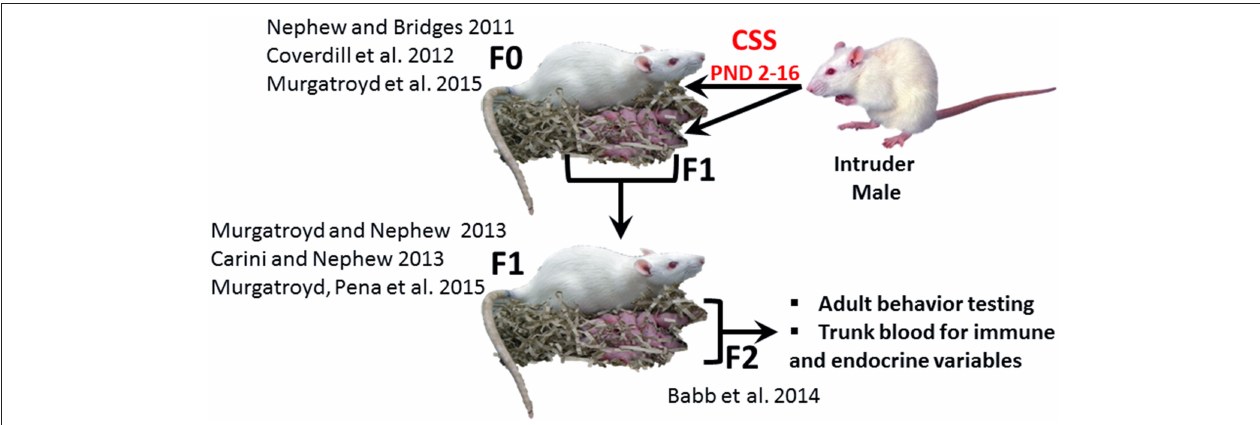
FIGURE 1 | The CSS model of postpartum depression and anxiety. F0 dams are exposed to novel male intruder stress for 1 h/day during lactation days 2–15. This social stress is early life stressor for the F1 generation. Both the F0 and F1 dams exhibit depressed maternal care and increased maternal anxiety, and the depressed maternal care of the F1 dams is an early life stressor for the F2 generation. The current study focused on male and female F2 adults. (F0: Nephew and Bridges, 2011; Coverdill et al., 2012; Murgatroyd et al., 2015b; F1: Carini and Nephew, 2013; Murgatroyd and Nephew, 2013; Murgatroyd et al., 2015a; F2: Babb et al.,